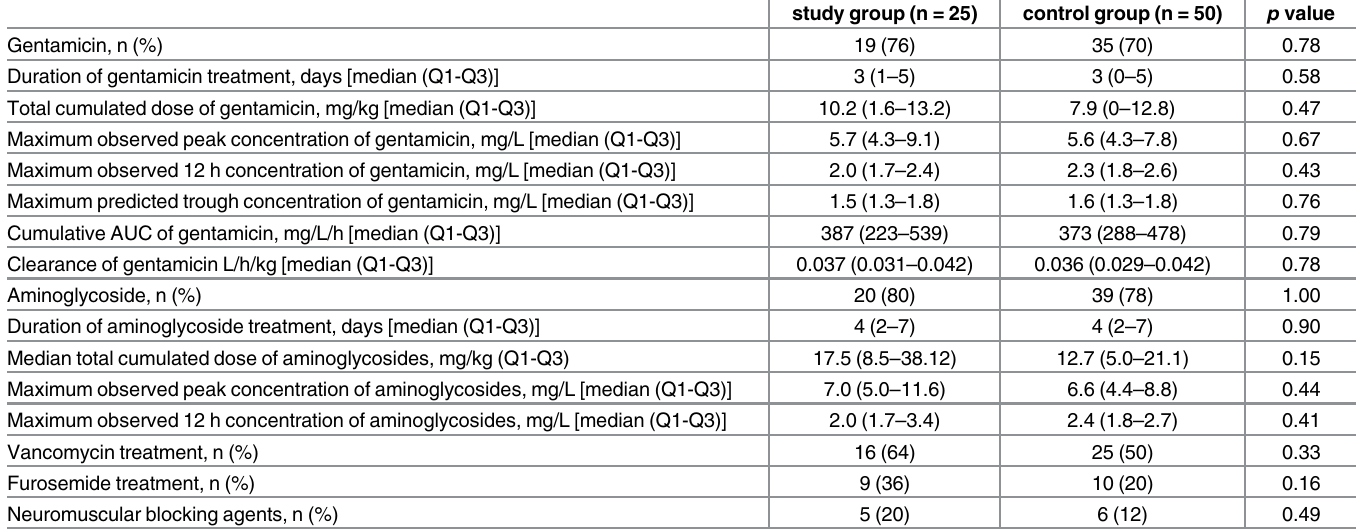
Table 3. Gentamicin and other potentially ototoxic